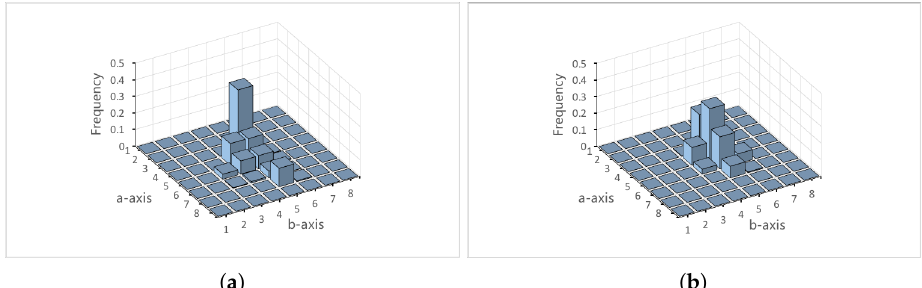
Figure 3. Original color histograms ( β 1 = 8, β 2 = 8). ( a ) Histogram P for image A. ( b ) Histogram Q for image B.